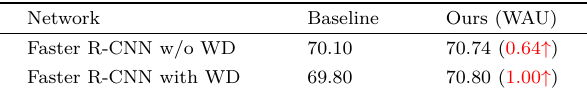
Table 3 Object detection accuracy (%) using Faster R-CNN [32] on the Pascal VOC 2007 test set. Models were trained on the Pascal VOC 2007 trainval set Network